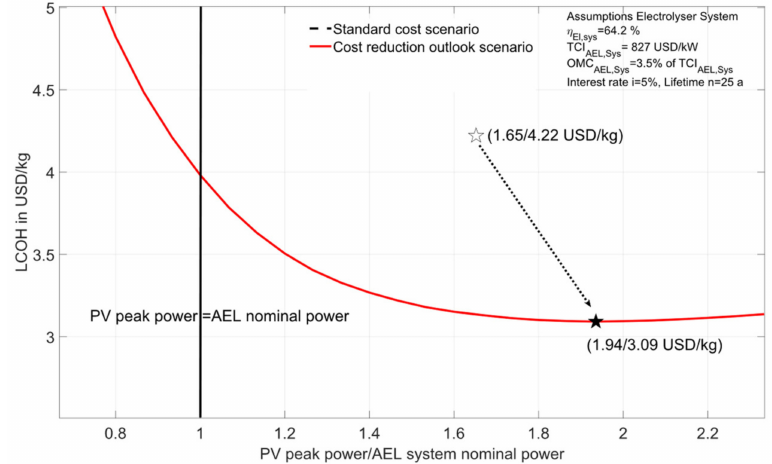
Figure 7. Levelized cost of hydrogen (LCOH) depending on the PV peak power to AEL nominal power ratio for the location Ouarzazate in Morocco. The study was performed for the standard cost scenario and the cost reduction outlook scenario.